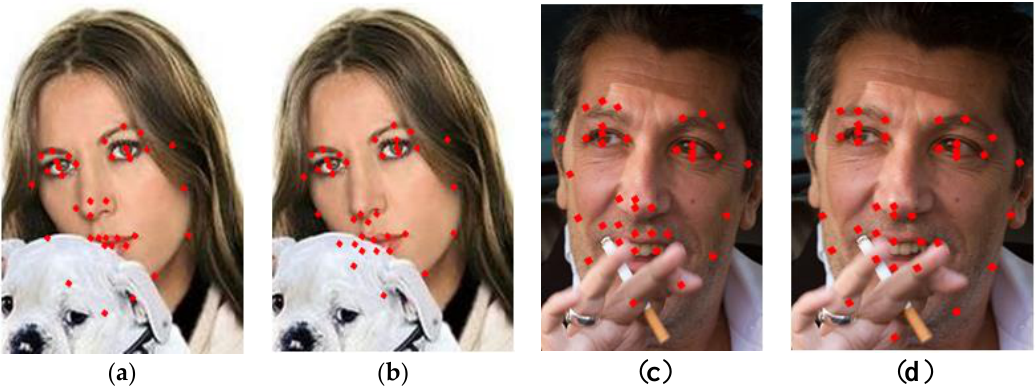
Figure 12. Improvement for the images under the different conditions. ( a ) local optima on the contours of chin due to partial occlusions; ( b ) the improvement for the influence of occlusion; ( c ) misalignment in eyebrow region caused by illumination variation; ( d ) improvement for the influence of